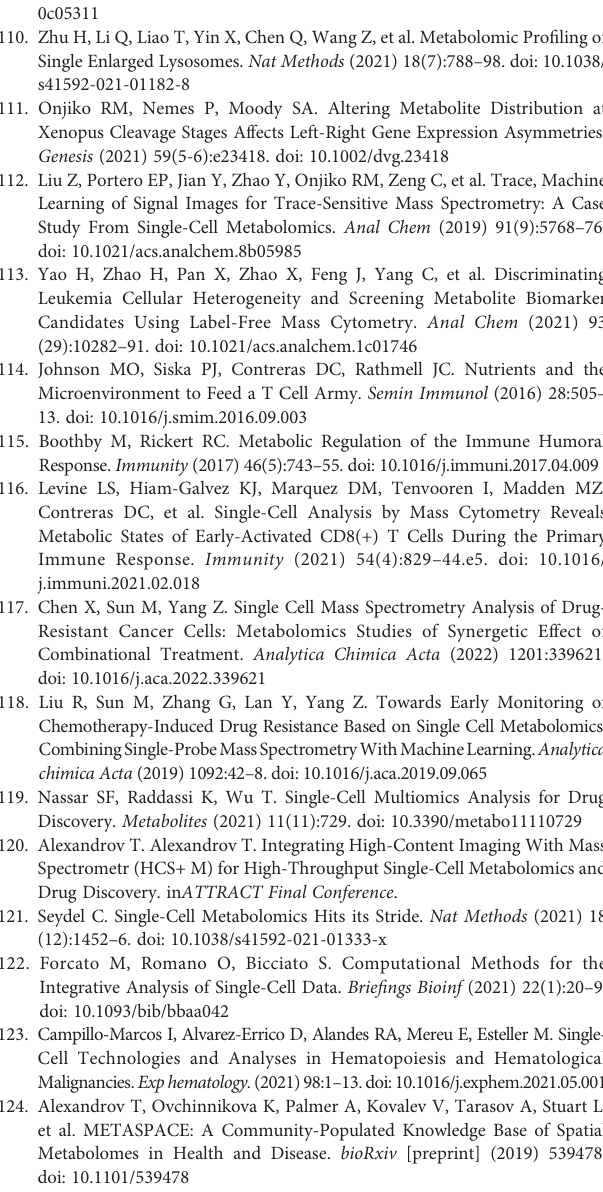
90. Tabe Y, Konopleva M, Andreeff M. Fatty Acid Metabolism, Bone Marrow Adipocytes, and AML. Front Oncol (2020) 10:155. doi: